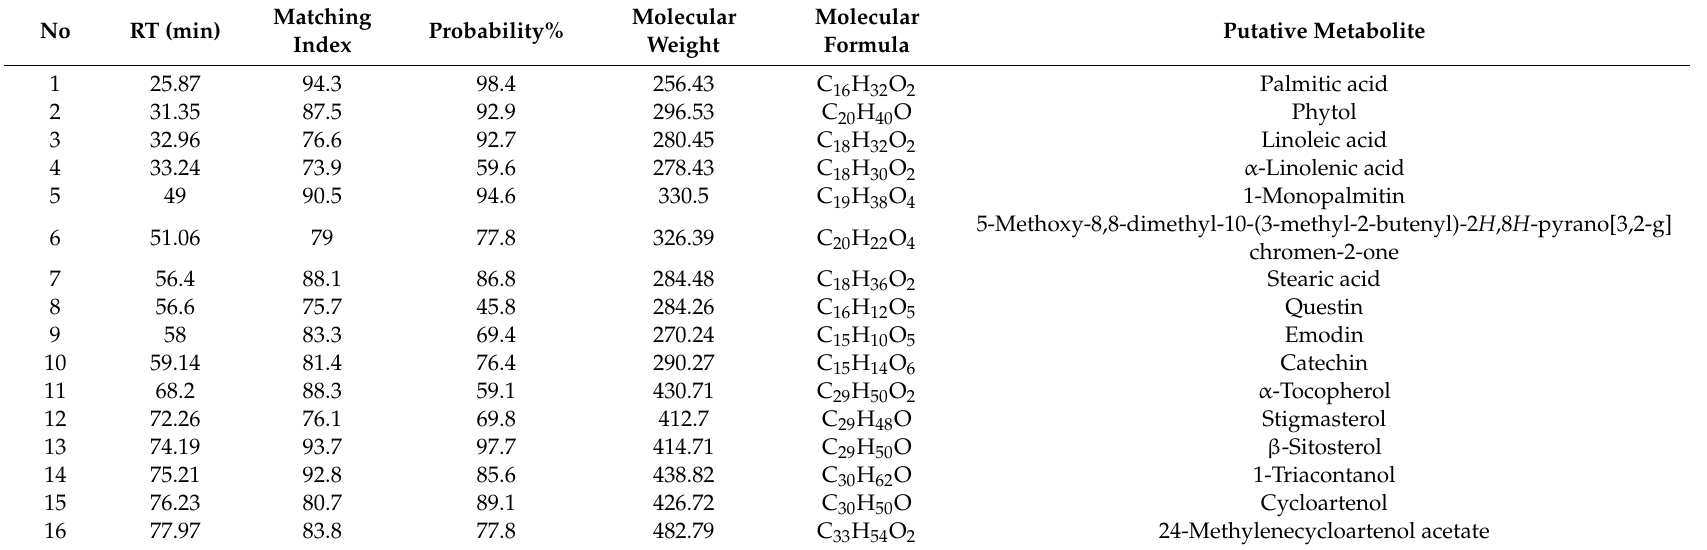
Table 1. α -Glucosidase inhibitory metabolites identified from T. scandens leaves extracts through GC–MS